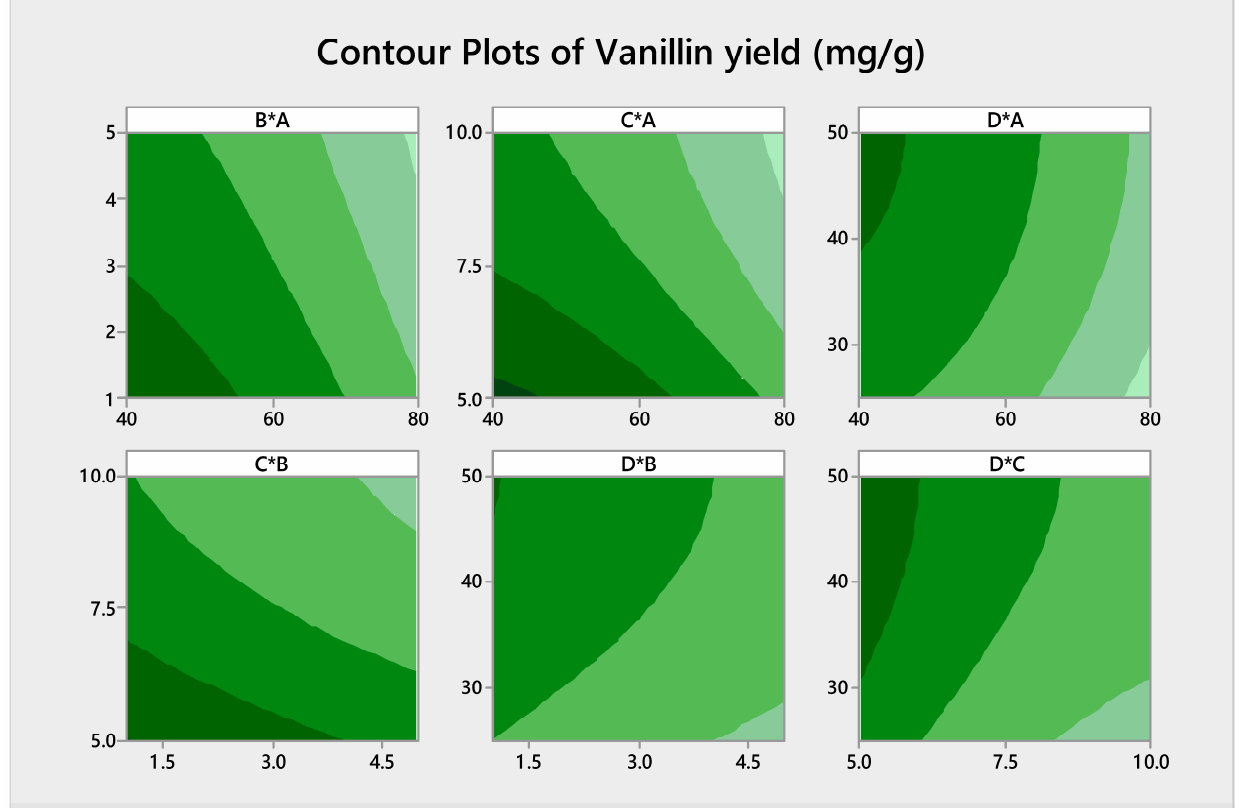
Figure 3. Contour plots for biovanillin production, specifying the interaction between different factors. The desirability chart for biovanillin production by Enterobacter hormaechei through solid-state fermentation is shown in Figure 4. These charts demonstrate that if the value of parameters A, B, C and D are set to 40.0%, 1.0 mL, 5.0, and 50.0 ◦ C, respectively, the maxi- mum predicted yield would be 0.4792 mg/g. When the values of the several parameters were compared, this response was close to the expected values, confirming the reliability of the model